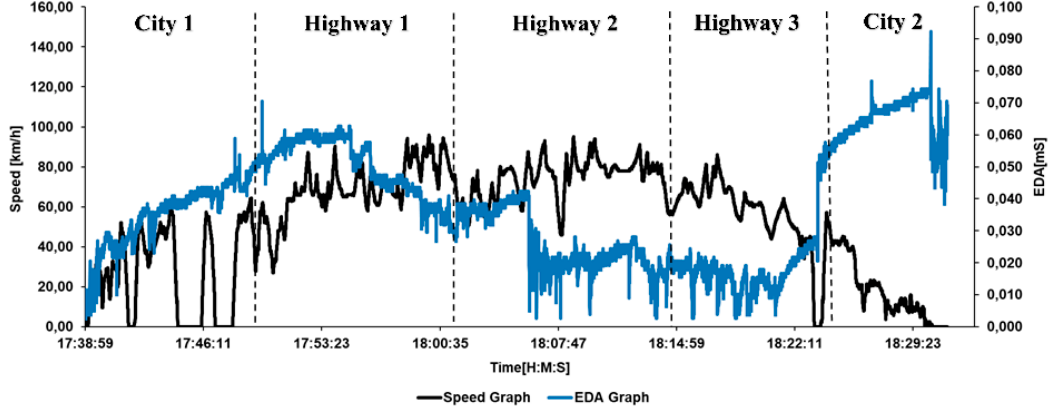
Figure 2. Experiment on the driving route between Incheon and Seoul (captured by Google Earth).